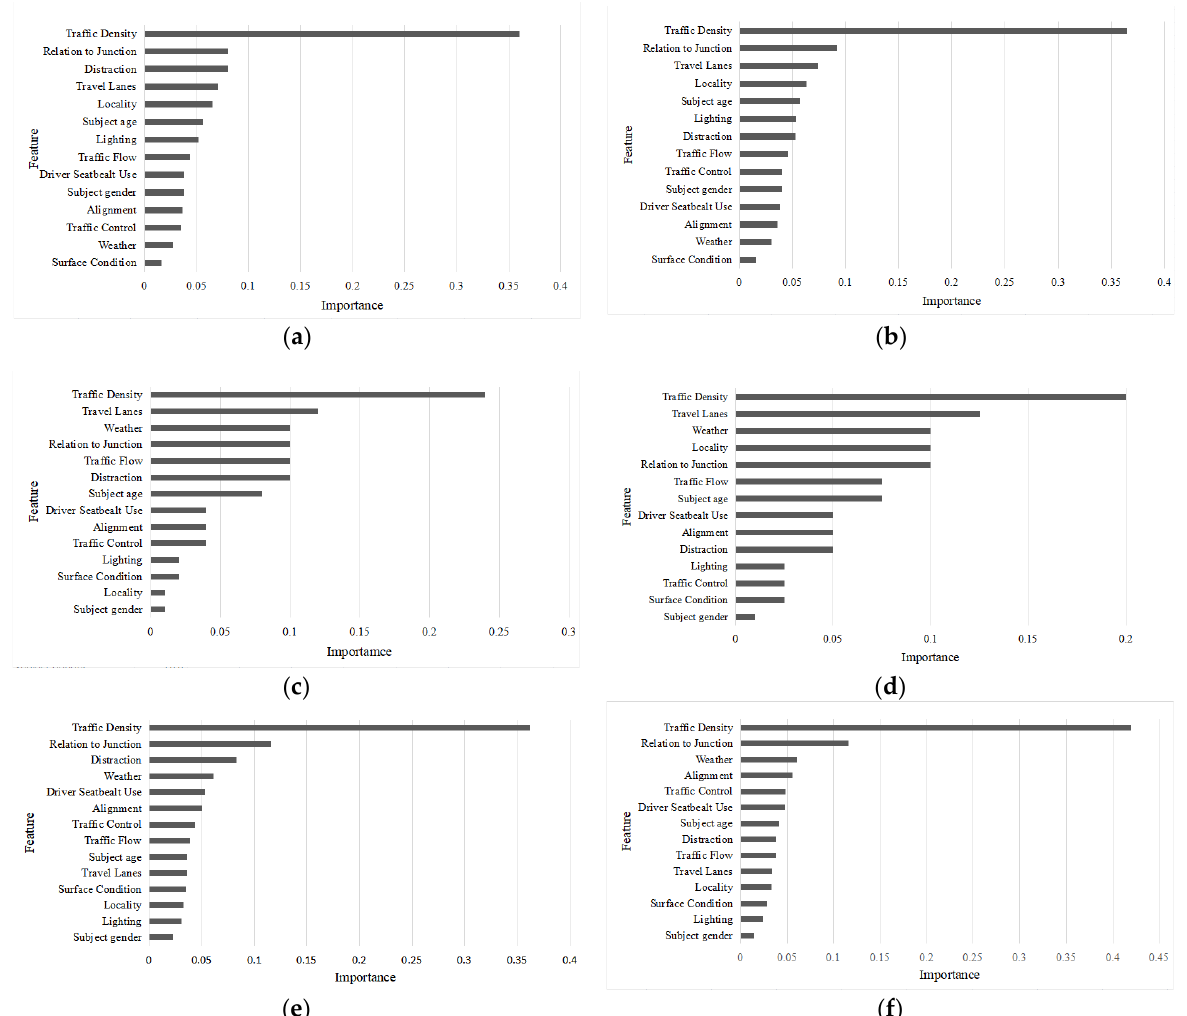
Figure 6. Importance of model feature: ( a ) gaze — random forest; ( b ) secondary driving task — random forest; ( c ) gaze — AdaBoost; ( d ) secondary driving task — AdaBoost; ( e ) gaze — XGBoost; ( f ) secondary driving task — XGBoost.